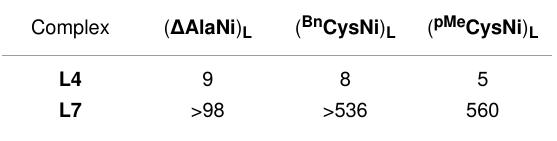
Table 3: The solubility (mg/1 mL of CH 3 CN) of the complexes derived from ligands L7 and L4 . Complex